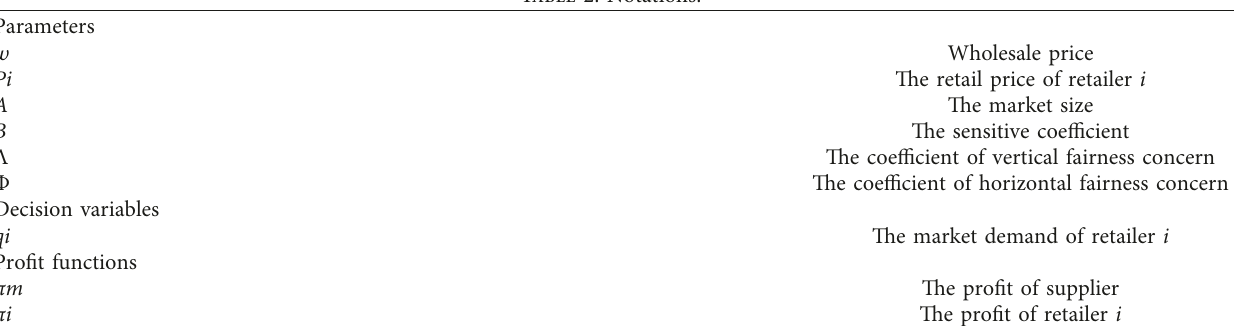
Figure 1: Competitive supply chain structure. (a) Vertical fairness concern. (b) Horizontal fairness concern. Table 2: